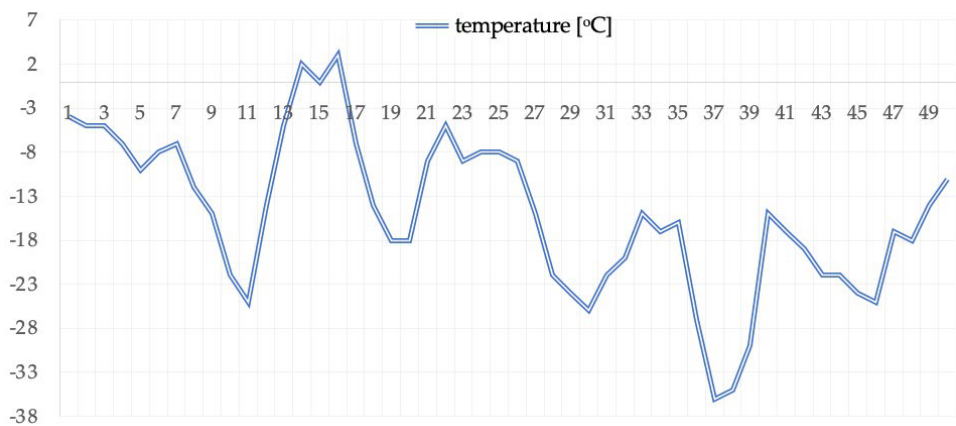
Figure 1. Air temperature changes during the expedition.